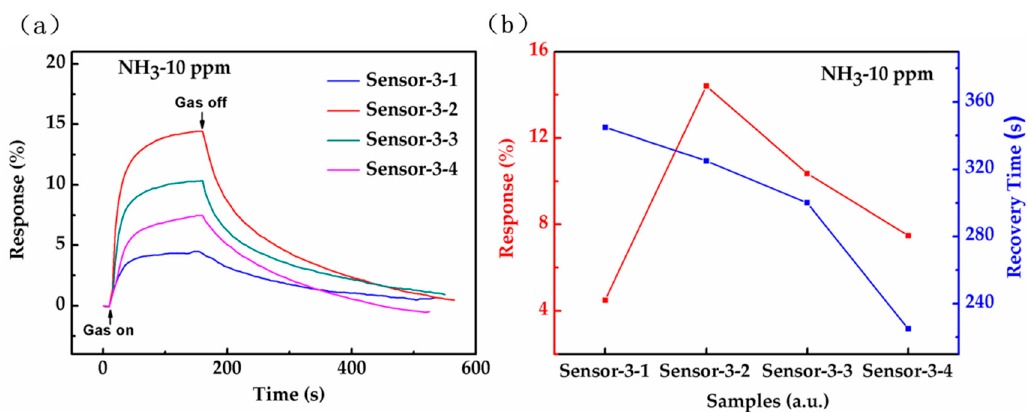
Figure 8. ( a ) Gas sensing response curves of four sensors to 10 ppm ammonia; ( b ) Gas sensing and recovery time of four sensors for 10 ppm ammonia. recovery time of four sensors for 10 ppm ammonia.